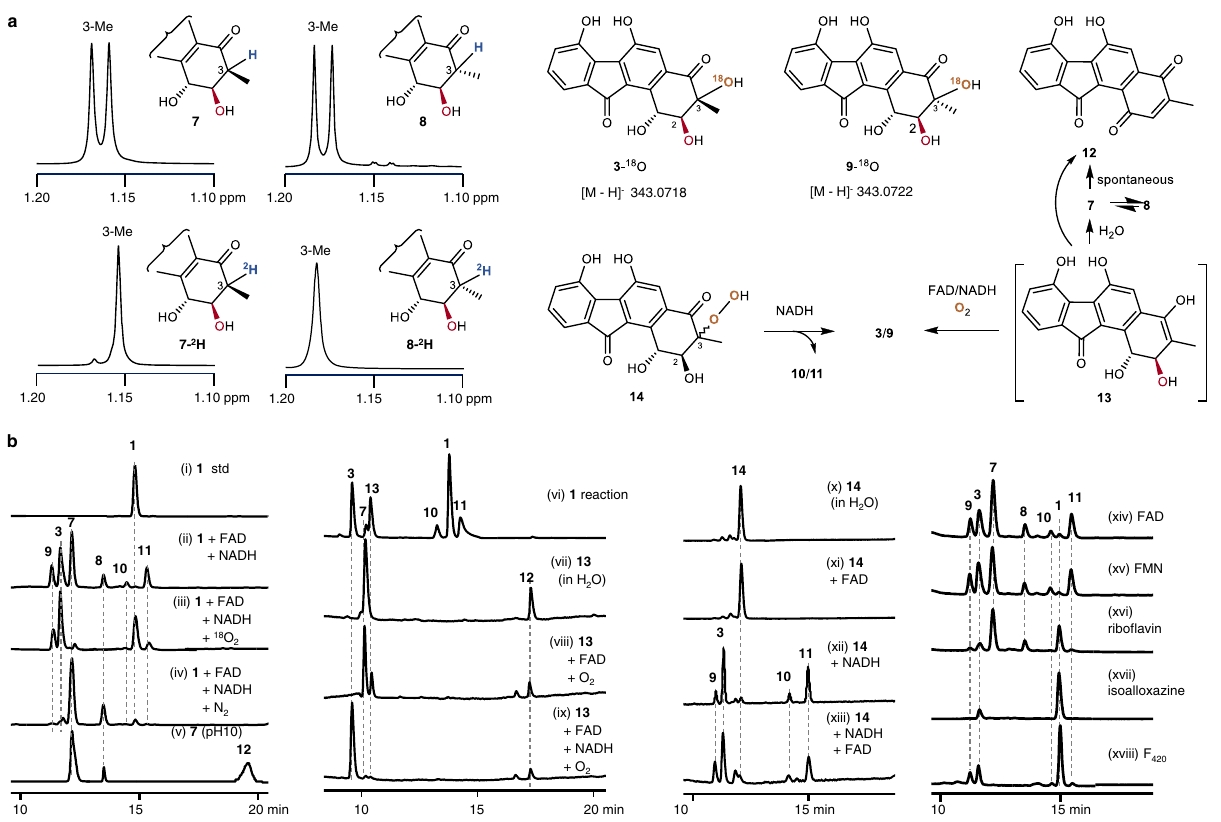
Fig. 3 | Detailed studies on the epoxide ring opening reactions of 1 by isotope labeling, intermediate characterization and cofactor compatibility. a NMR analysis of 2 H or 18 O incorporation in products and intermediates as well as potential interconversions. Deuterium incorporation from 2 H 2 O at C-3 of 7 and 8 wasinferredfrom 1 HNMRspectroscopicanalysis.TheO 18 -labelingin 3 - 18 Oand 9 - 18 O was supported by HRMS analysis. The assigned structures of 12 and 14 are shown, whereas the proposed structure of 13 remains speculative on account of its poor stability. b HPLC analysis of reactions under varying conditions. (i) 1 std.; (ii) 1 +FAD+NADH (in air); (iii) 1 +FAD+NADH (under 18 O 2 ); (iv) 1 +FAD+NADH (underN 2 );(v) 7 in50mMborax/NaOHbuffer(pH10)at30°Cfor12h;(vi)100 μ M